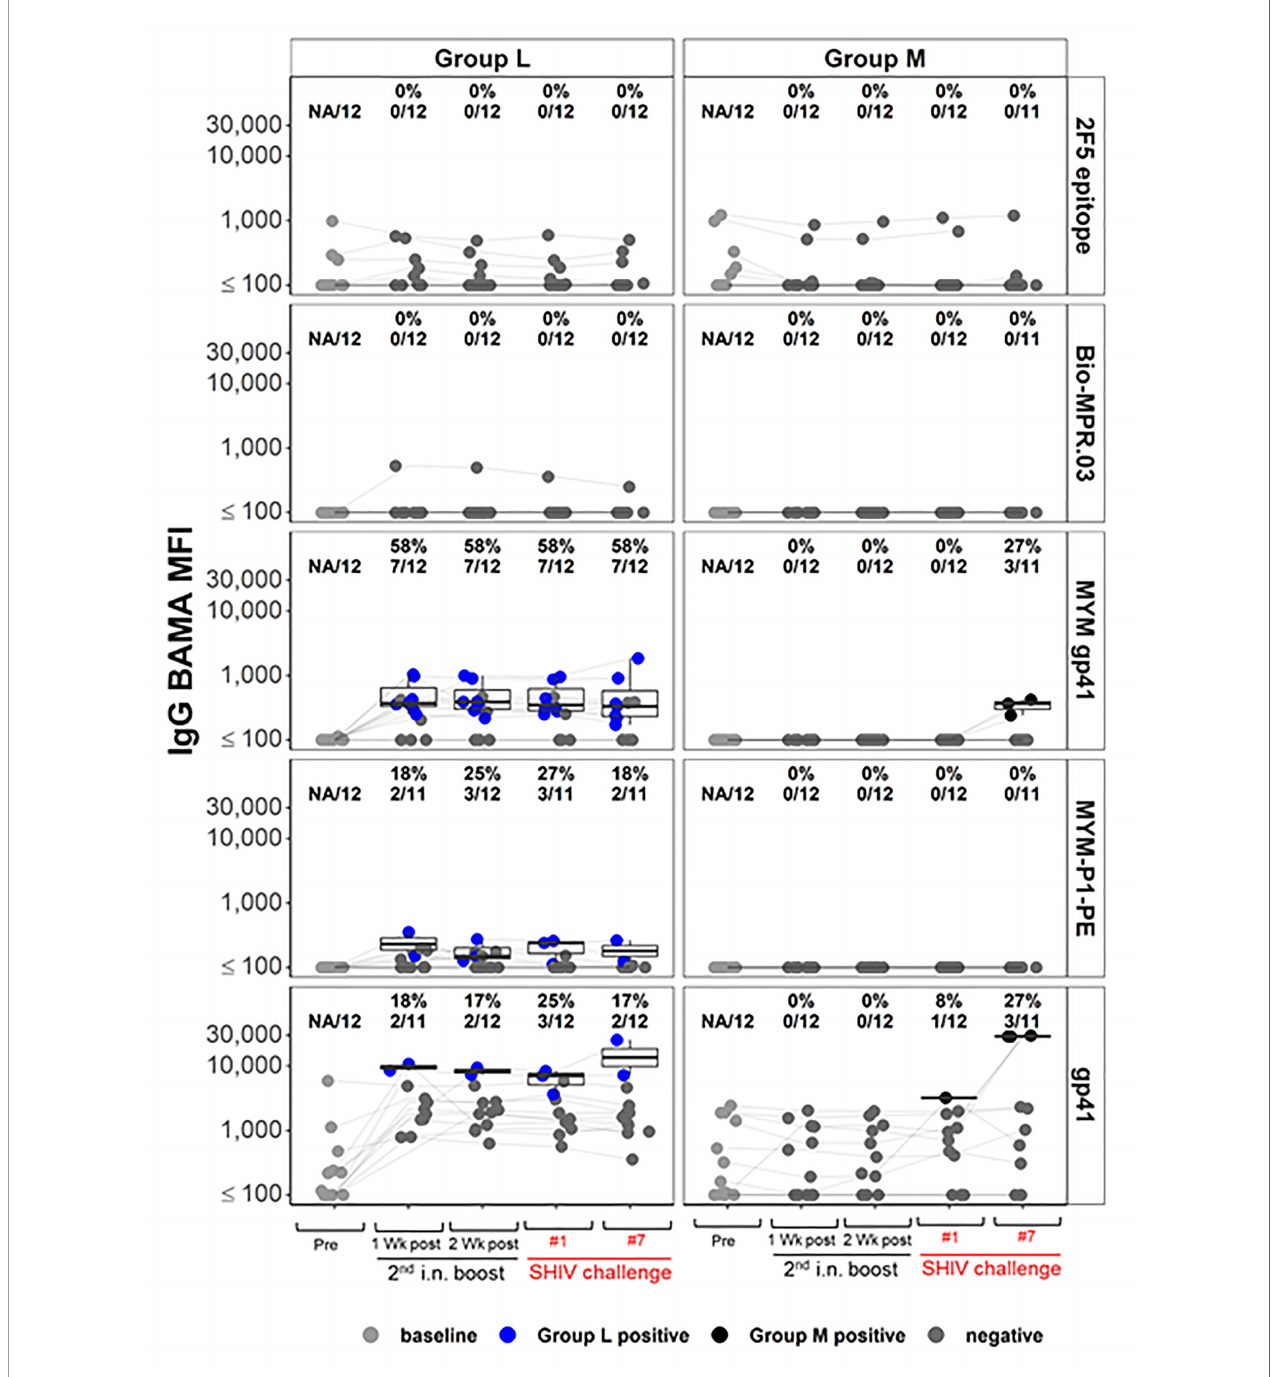
FIGURE 9 | IgG Binding Antibody Multiplex Assay (BAMA) response magnitude measured by Mean Fluorescence Intensity (MFI), for the vaccine groups L and M, by time point and antigen (Methods). Dots are colored by response status with boxplots displaying distributions among positive responders. Baseline (pre) and negative samples are shown in shades of grey color; blue and black dots show positive samples for Groups L (immunized with the combination of virosome-P1 + virosome- rgp41) and M (given placebo virosomes), respectively. Response rates [percent positive, and ratio of number of positive samples/total number of samples] are shown for each combination. Lines join the same animal over time. High background reactivity against some gp41 antigens is notable for some